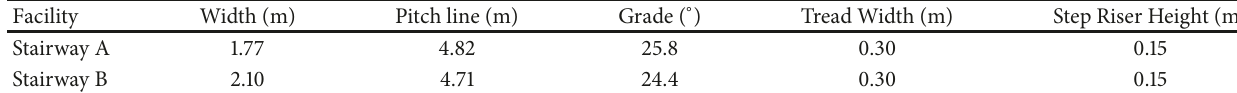
Table 1: Physical parameters of the two observed stairways.